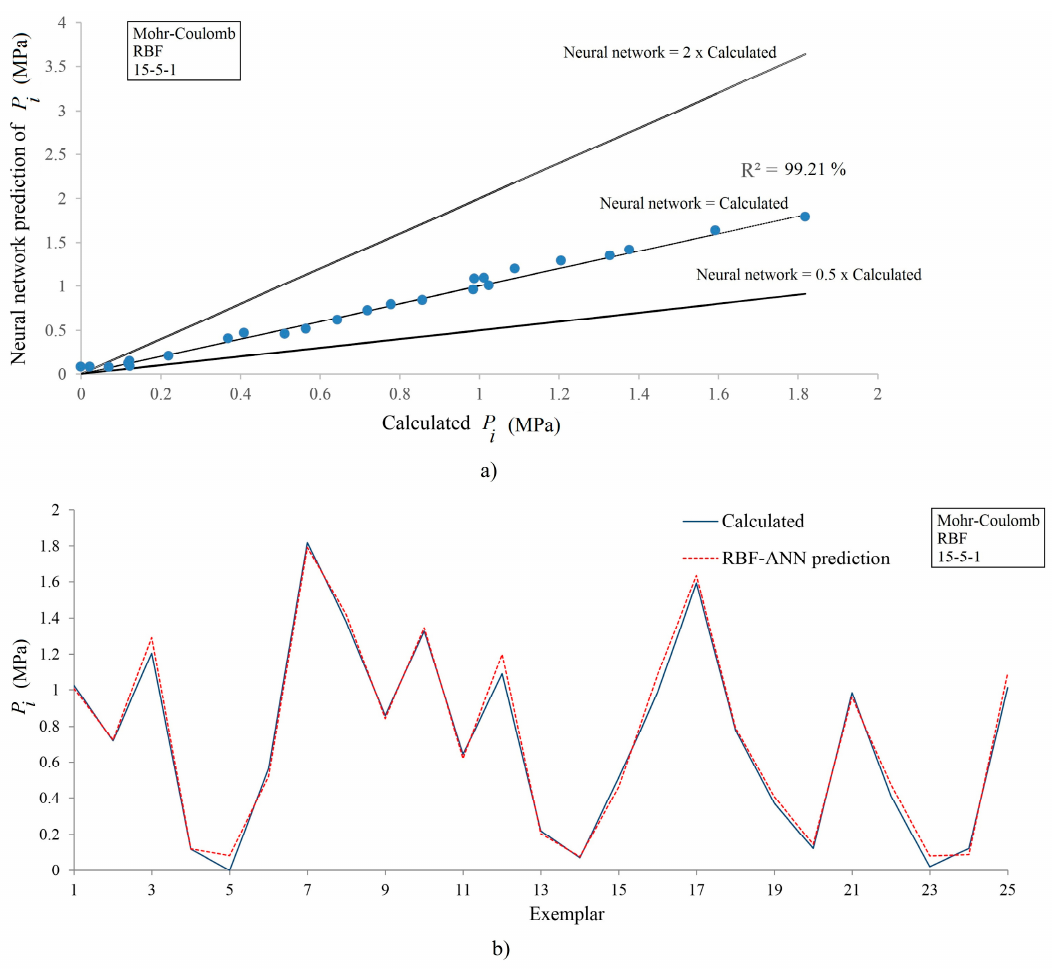
Figure 4. ( a ) ANN-based predicted P i versus calculated P i ; ( b ) differences between ANN-based predicted P i and calculated P i for the best RBF-ANN (15-15-1) for the Mohr–Coulomb criterion.